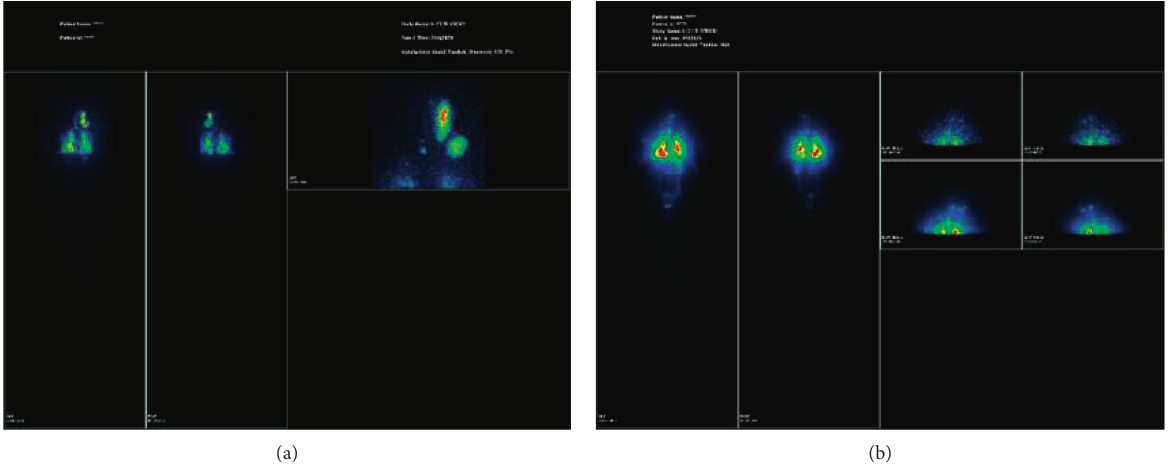
Figure 2: (a) I 123 and (b) I 131 show increased nonuniform uptake in level II, III, and IV cervical lymph nodes, mild residual uptake in the thyroid bed, and increased uptake in the lungs